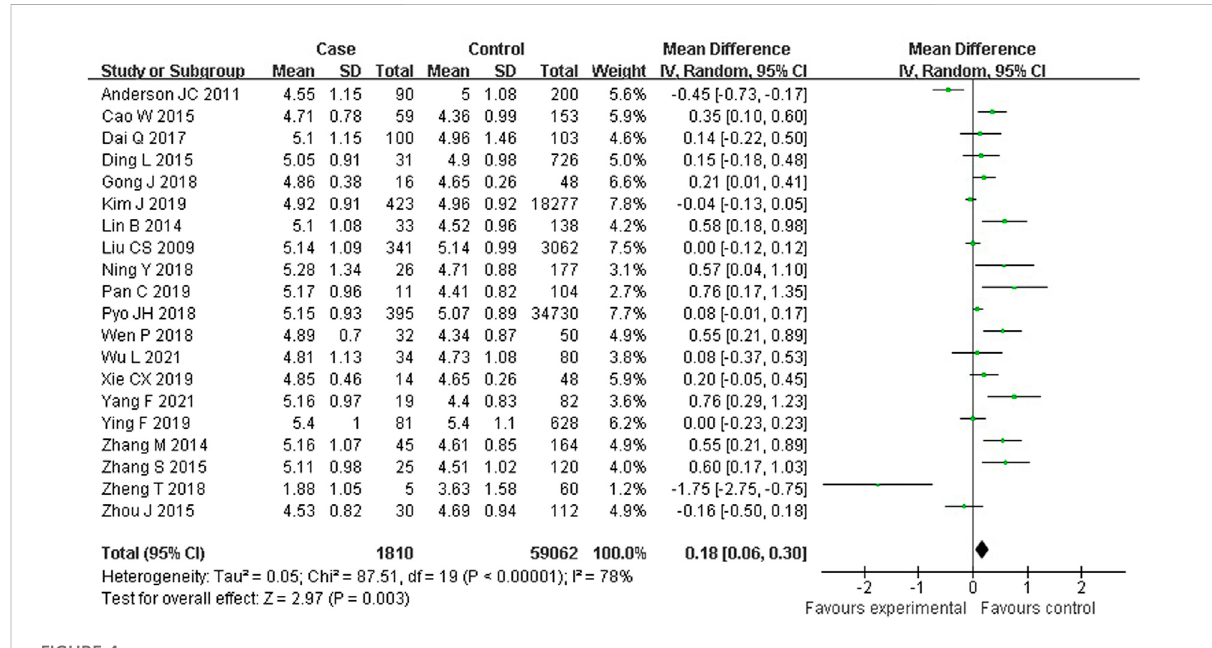
FIGURE 4 Forest plot of meta-analysis for association of serum TC and colorectal serrated